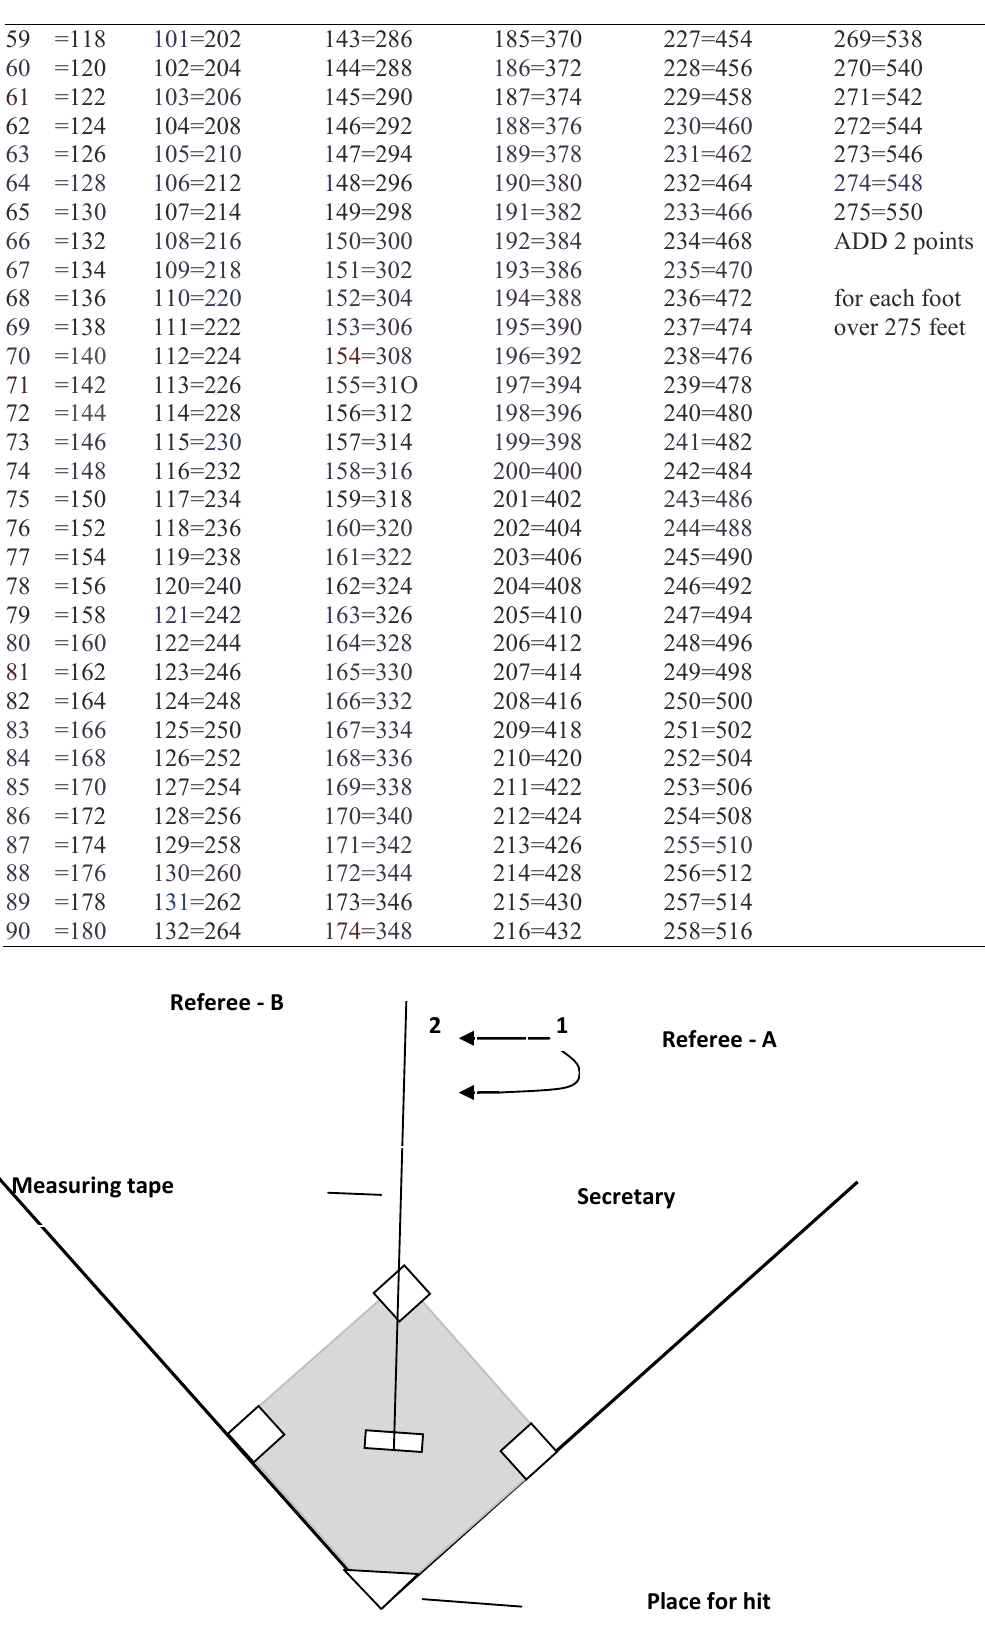
Fig 2. Diagram of “Hit”